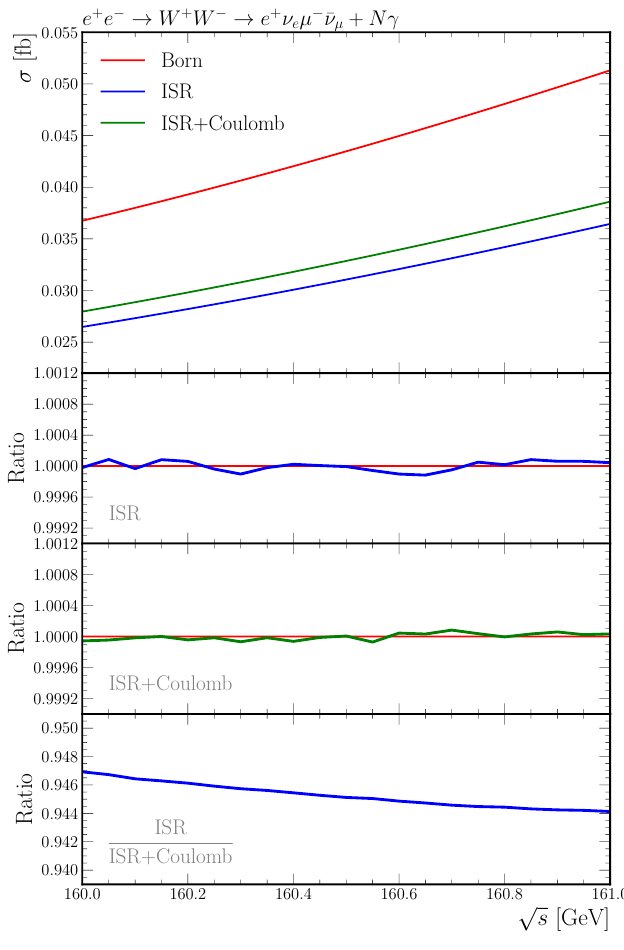
Figure 6: The effect of ISR and the Coulomb exchange at the WW threshold, with the ratio taken with respect to Y FS WW. The ISR reduces the total cross-section by about 30% and the Coulomb correction enhancement is of order